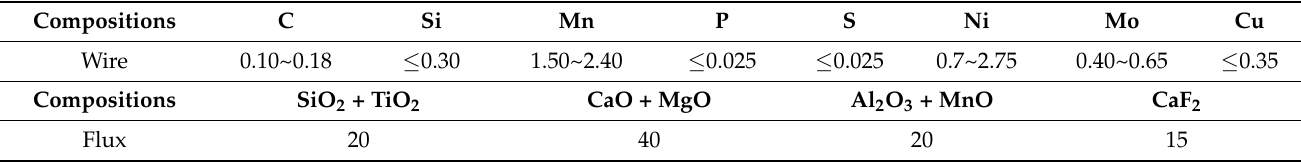
Table 3. Chemical compositions (wt%) of the flux and wire used in the welding process.